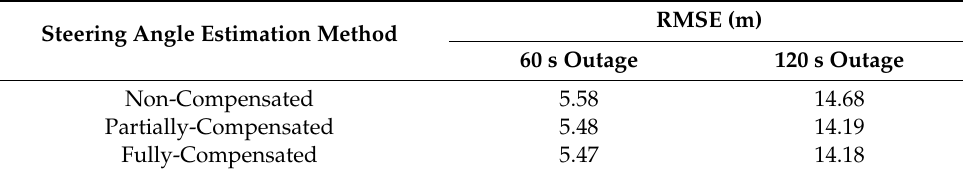
Table 3. Average RMSE of the integrated 2D position states for heading change and velocity updates for different GNSS signal outage periods.